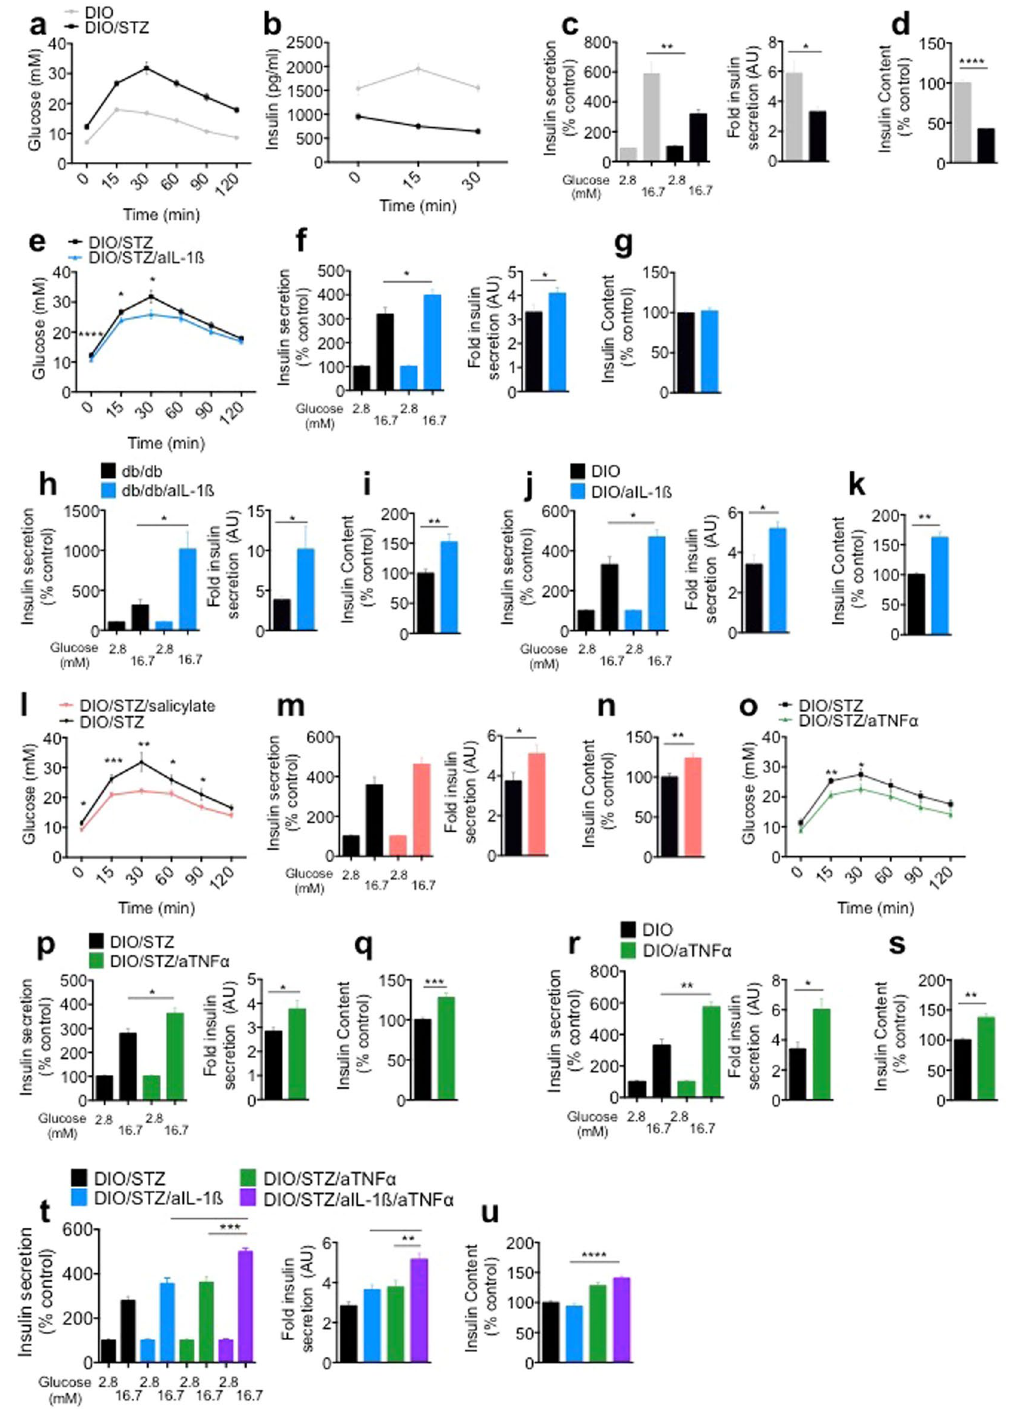
Figure 3. In vivo anti-inflammatory treatment ameliorates diabetic phenotype and improves β -cell insulin secretion capacity. ( a ) Glucose levels and ( b ) corresponding insulin levels following an ipGTT in DIO and DIO/ STZ mice. ( c , d ) GSIS, corresponding fold insulin secretion and insulin content of isolated islets from DIO and DIO/STZ mice. ( e ) Glucose levels following an ipGTT in DIO/STZ mice ± anti-IL-1 β (aIL-1 β ). ( f , g ) GSIS, corresponding fold insulin secretion and insulin content of isolated islets from DIO/STZ mice ± aIL-1 β . ( h – k ) GSIS, corresponding fold insulin secretion and insulin content of isolated islets from ( h , i ) db/db mice ± aIL-1 β treatment for 2 weeks and ( j , k ) DIO mice ± aIL-1 β treatment for 8 weeks. ( l ) Glucose levels following an ipGTT in DIO/STZ mice ± sodium salicylate. ( m , n ) GSIS, corresponding fold insulin secretion and insulin content of isolated islets from DIO/STZ mice ± sodium salicylate treatment. ( o ) Glucose levels following an ipGTT in DIO/STZ mice ± anti TNF α (aTNF α ) treatment. ( p , q ) GSIS, corresponding fold insulin secretion and insulin content of isolated islets from DIO/STZ mice ± aTNF α treatment. ( r , s ) GSIS and corresponding fold